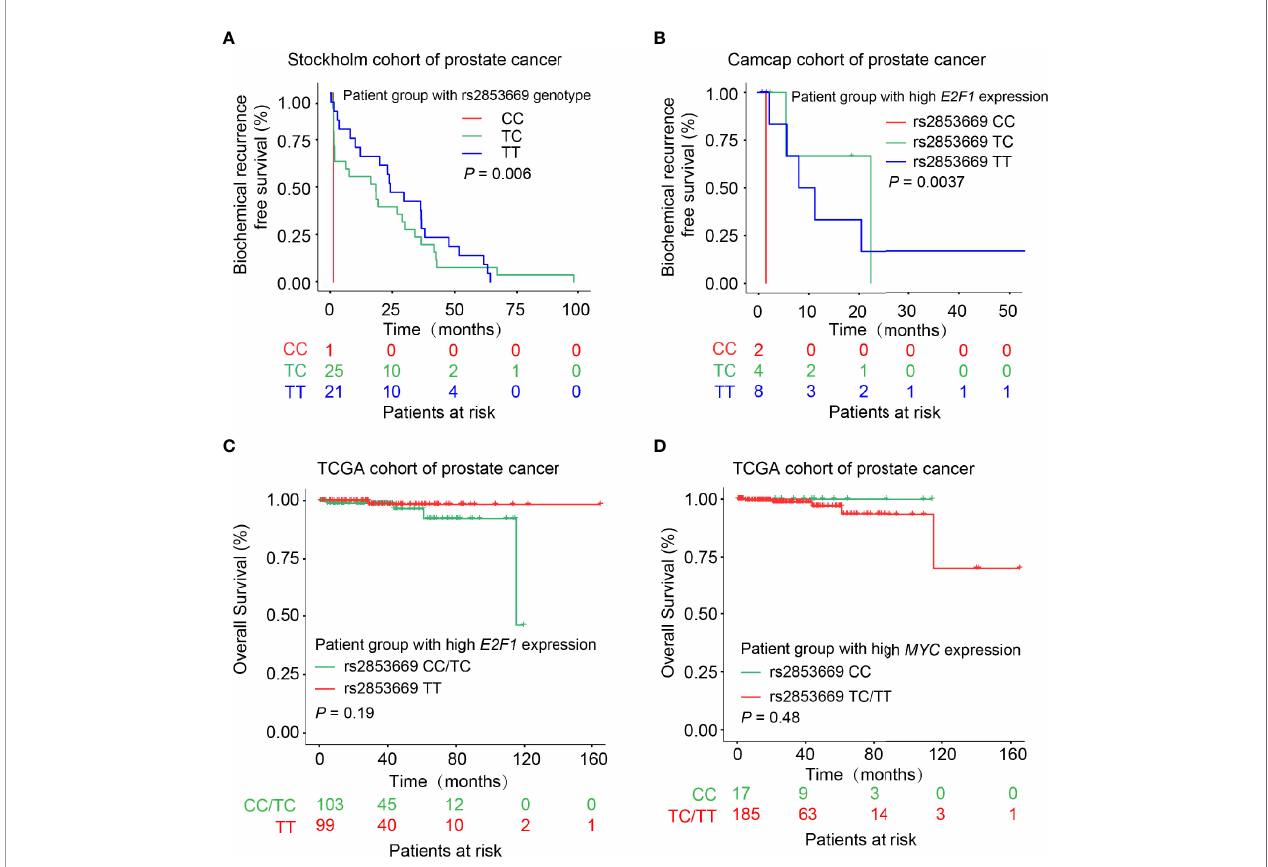
FIGURE 7 | Effect of rs2583669 genotype on PCa patient prognosis. (A, B) Kaplan – Meier plots demonstrating the biochemical recurrence-free survival of PCa patients grouped by the genotype of rs2853669. Patients carrying C allele of rs2853669 correlated with increased risk for biochemical recurrence in the Stockholm cohort (A) . Patient group with high E2F1 expression and carrying rs2853669 CC genotype underwent a higher biochemical recurrence risk (B) . (C, D) PCa patient group carrying rs2853669 C allele with higher E2F1 expression tumors or T allele with higher MYC expression levels indicated an increased risk of overall survival. p- values were examined by a log-rank